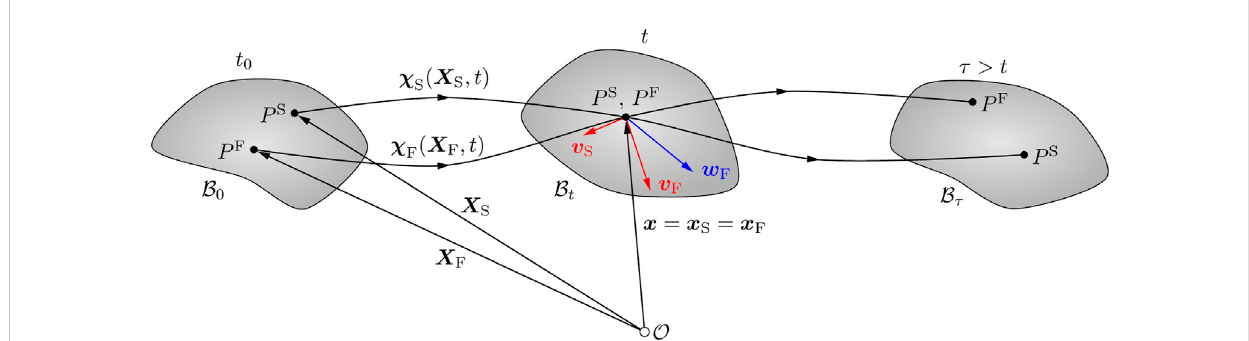
FIGURE 2 Kinematicsofabiphasic material body within thecontext oftheTheory ofPorous Media (Ehlers and Eipper,1999). Thematerialparticlesof thesolid and fl uidcomponents( P S and P F ,respectively)originatefromdifferentreferencepositionsinthematerialcon fi guration B 0 attheinitialtime t 0 ,butoccupy the same spatial position in the current con fi guration B t at time t . Adapted from Ehlers